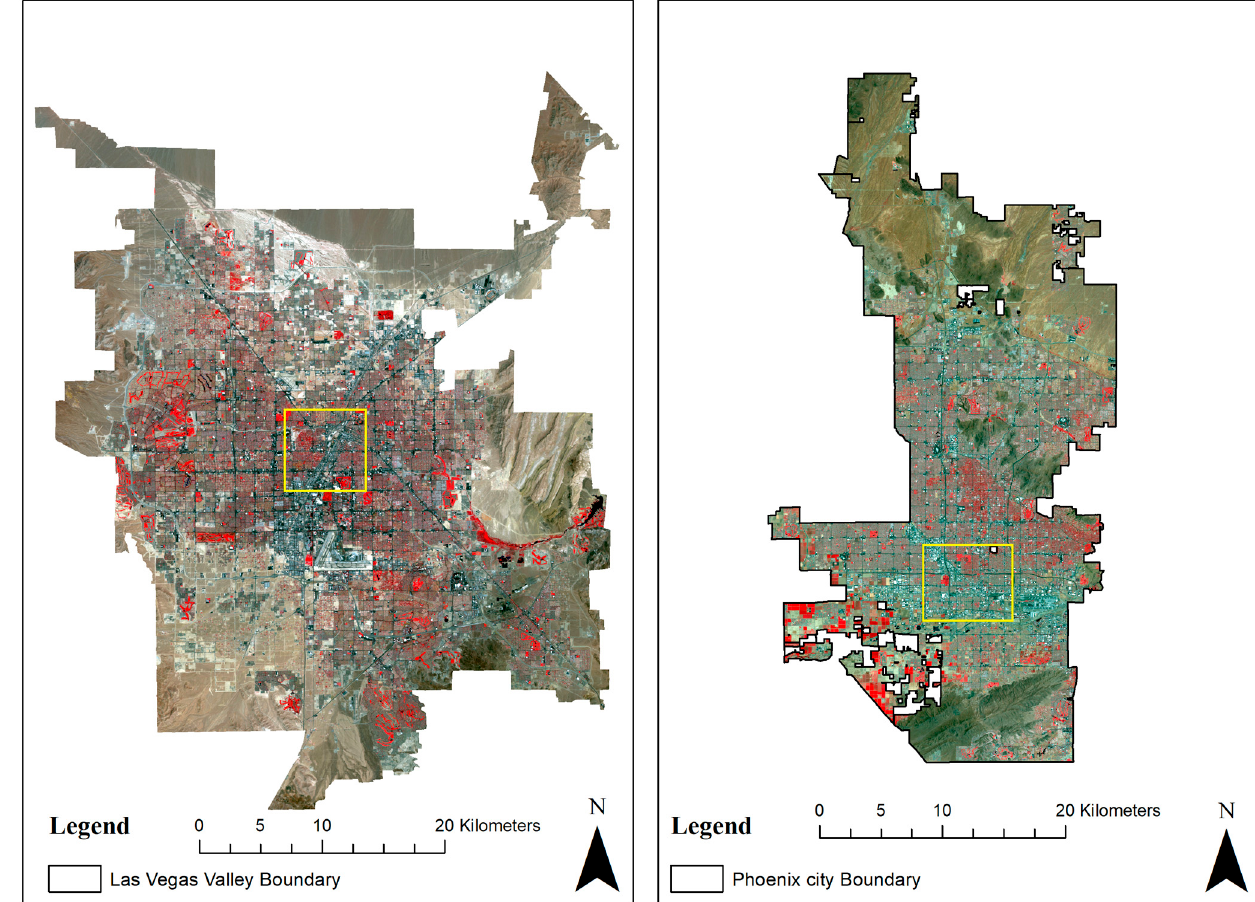
Figure 1. Study area map retrieved from the OLI-sensor dataset (July 2017) of Las Vegas Valley, NV, and Phoenix, AZ; yellow squares show the focused area for the analysis considered.